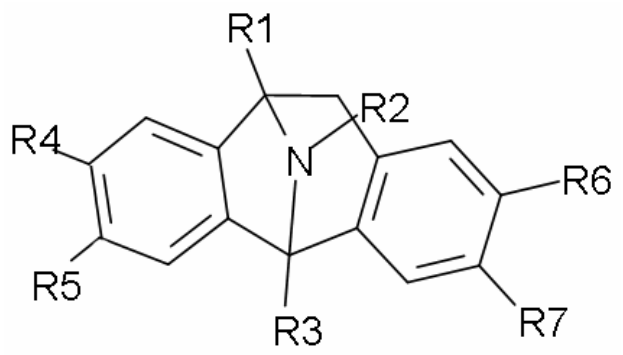
Figure 1. The general structure of studied compounds' series (MK801